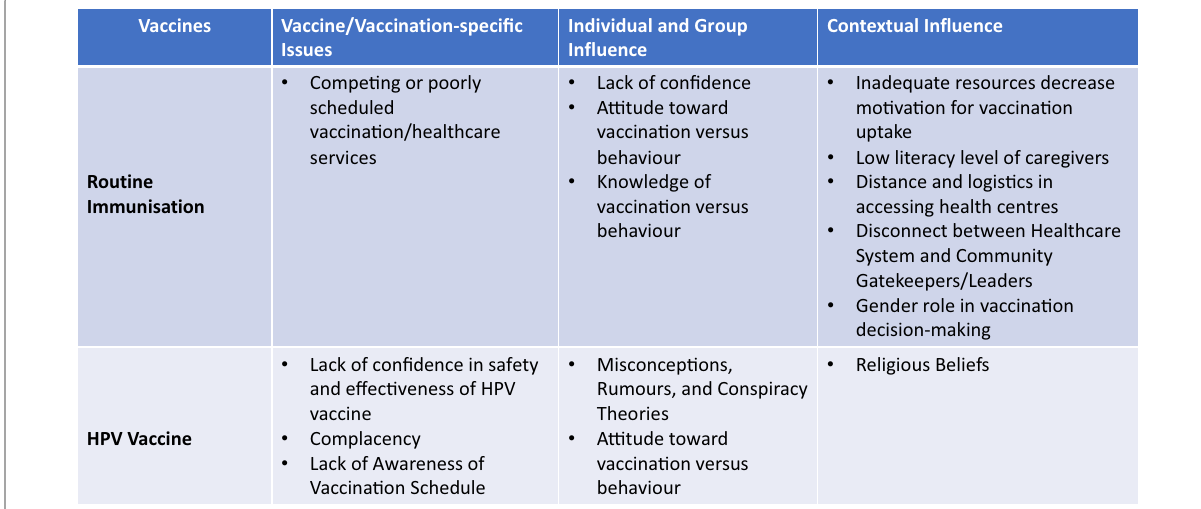
Fig. 2 Results summary based on WHO SAGE vaccine hesitancy determinant model. HPV Human